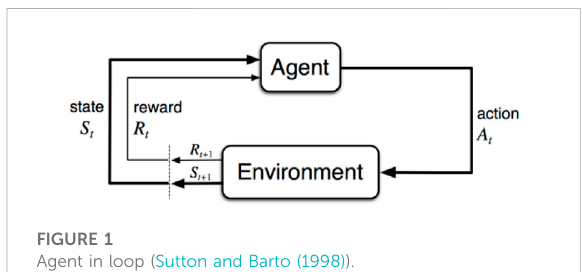
FIGURE 1 Agent in loop (Sutton and Barto